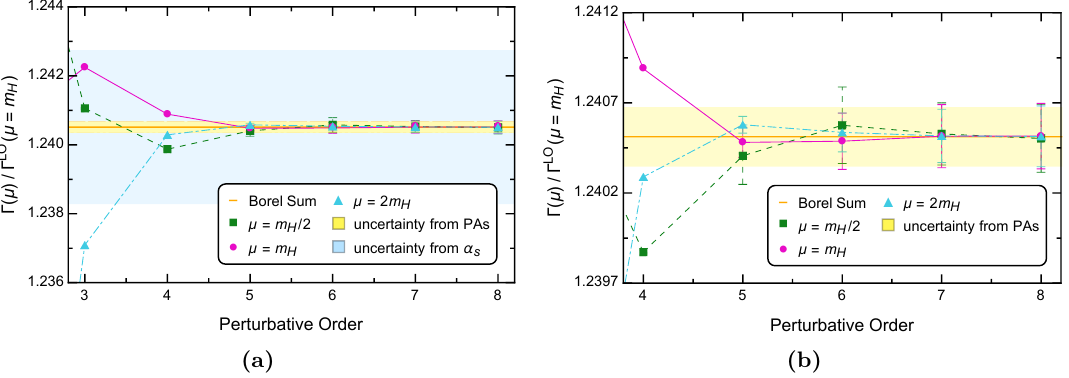
Figure 3. Perturbative expansion of the normalized decay rate eq. (5.3) in QCD at three different renormalization scales using the coefficients of table 4 for the coefficients c n ≥ 5 and the integral given in eq. (5.2). The uncertainty of the Borel integral is due to (a) the strong coupling uncertainty (light- blue band) and (b) the different Padé predictions (light-yellow band). The uncertainty from m b es- sentially cancels in eq. (5.3). The error bars of the points in (b) are due to the errors of the predicted coefficients. The α s uncertainty is omitted in (b) since it would be too large for the scale of the